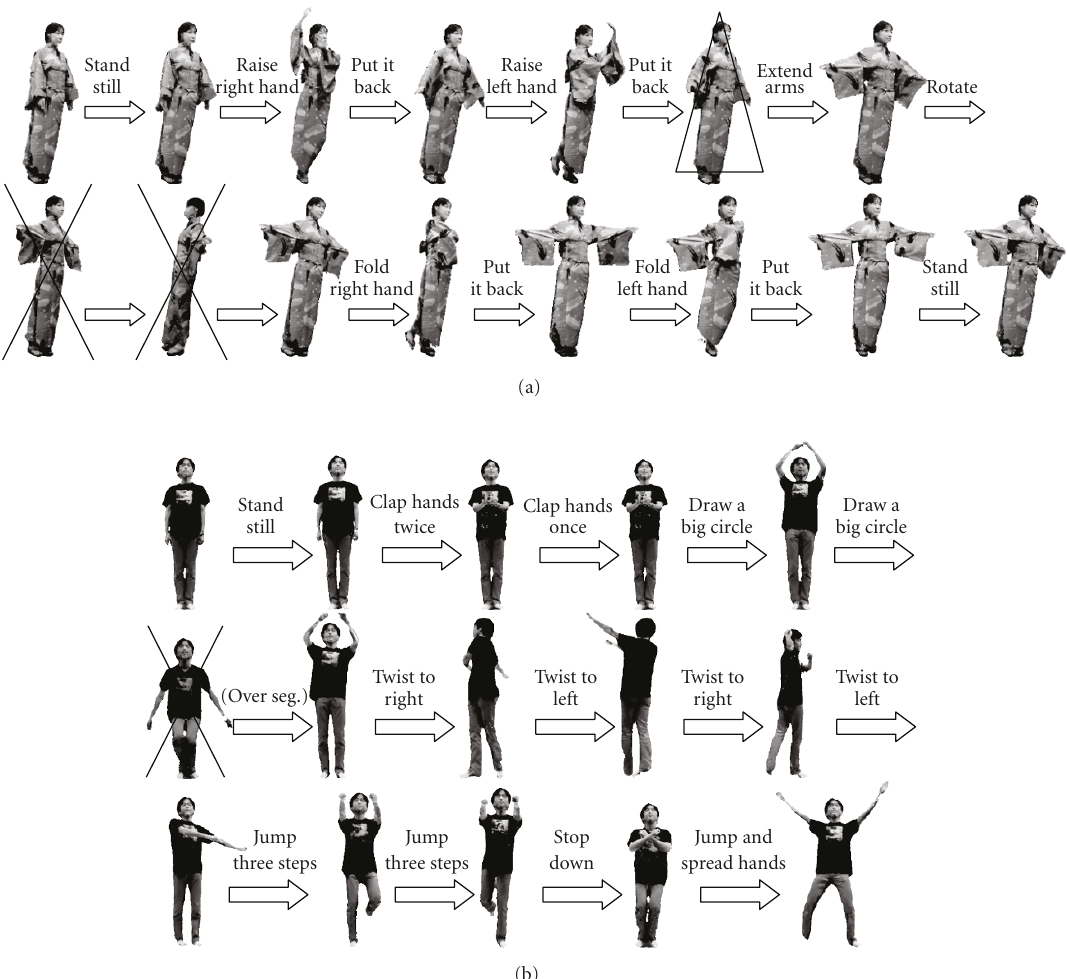
Figure 5: Motion segmentation results: (a) #1, (b) #2-1. Images with a cross represent over-segmentations and that with a triangle is a miss-segmentation.